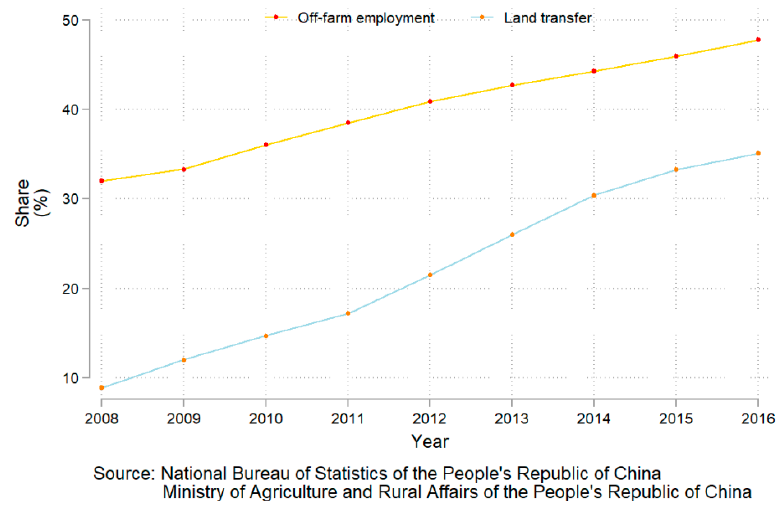
Figure 1. Share of off-farm employment and land transfer.